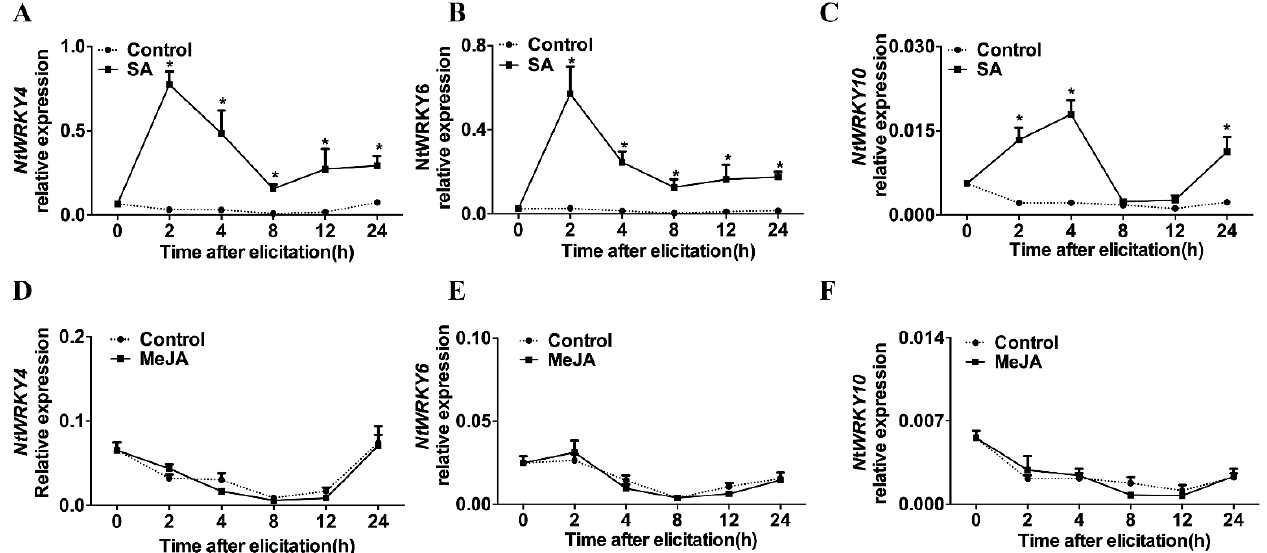
Figure 2. Expression levels of NtWRKY4 , NtWRKY6 , and NtWRKY10 after salicylic acid (SA) and Methyl jasmonate acid (MeJA) treatments. ( A – C ) Effect of SA application on the expression of NtWRKY4 , NtWRKY6 , and NtWRKY10 ; ( D – F ) effect of MeJA application on the expression of NtWRKY4 , NtWRKY6 , and NtWRKY10 . Three or four replicates were conducted per treatment. The expression levels of the control and SA (or MeJA) treatment at each time point were analyzed using Student’s t test at a significance of * p < 0.05.